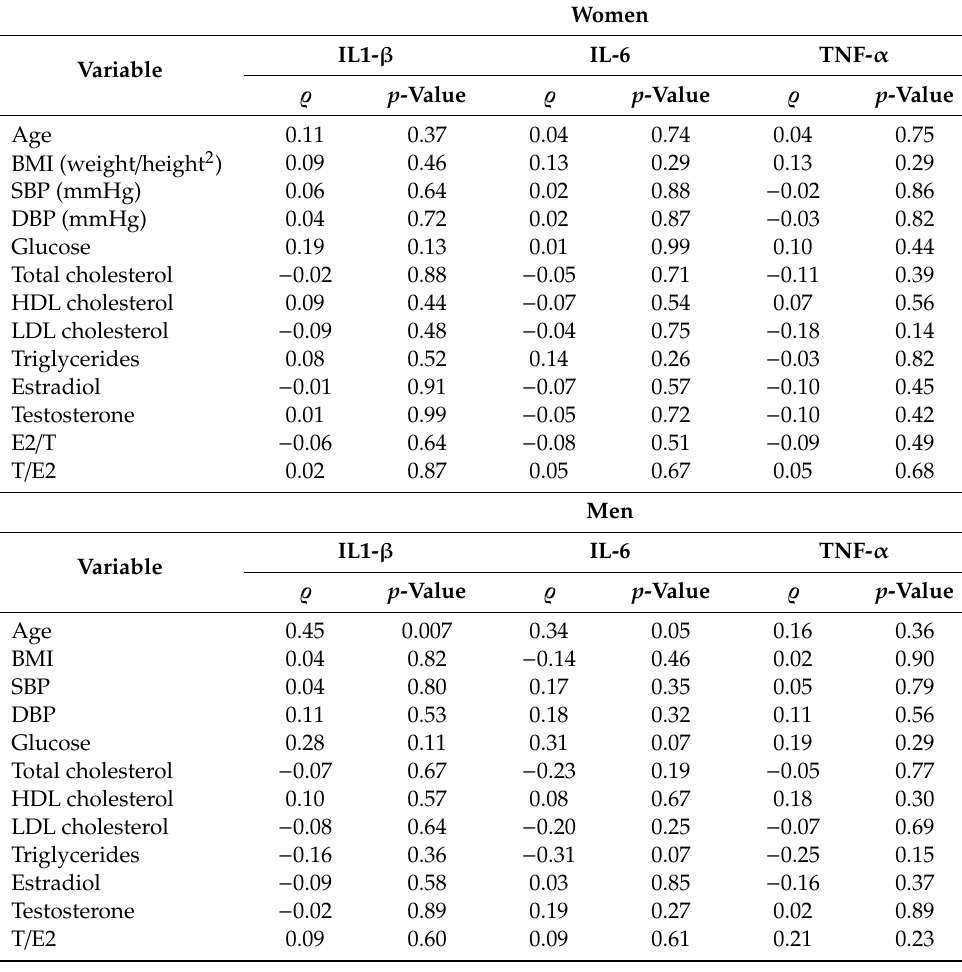
Table 3. Correlation between proinflammatory cytokines and clinical / hormonal variables in the subgroups of women and